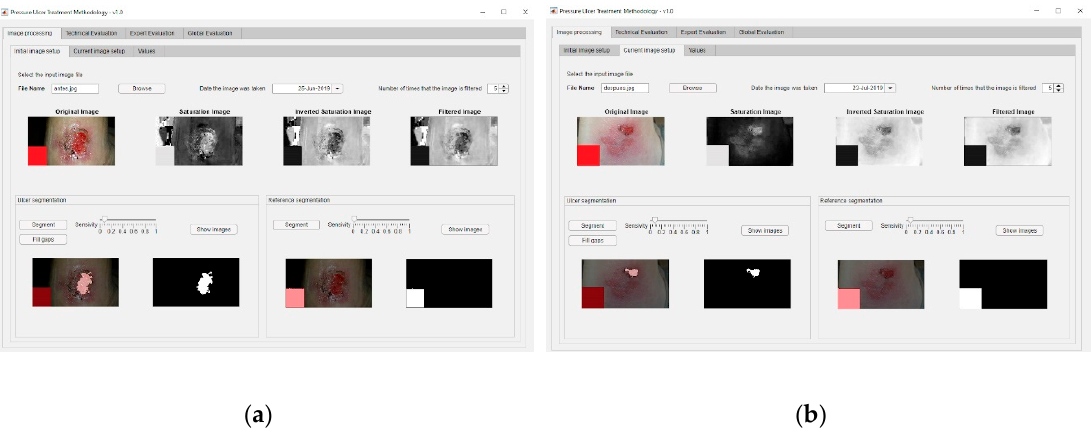
Figure 18. Photographs of the wounds: ( a ) initial picture; ( b ) current picture; ( c ) initial picture, modified; ( d ) current picture, modified.